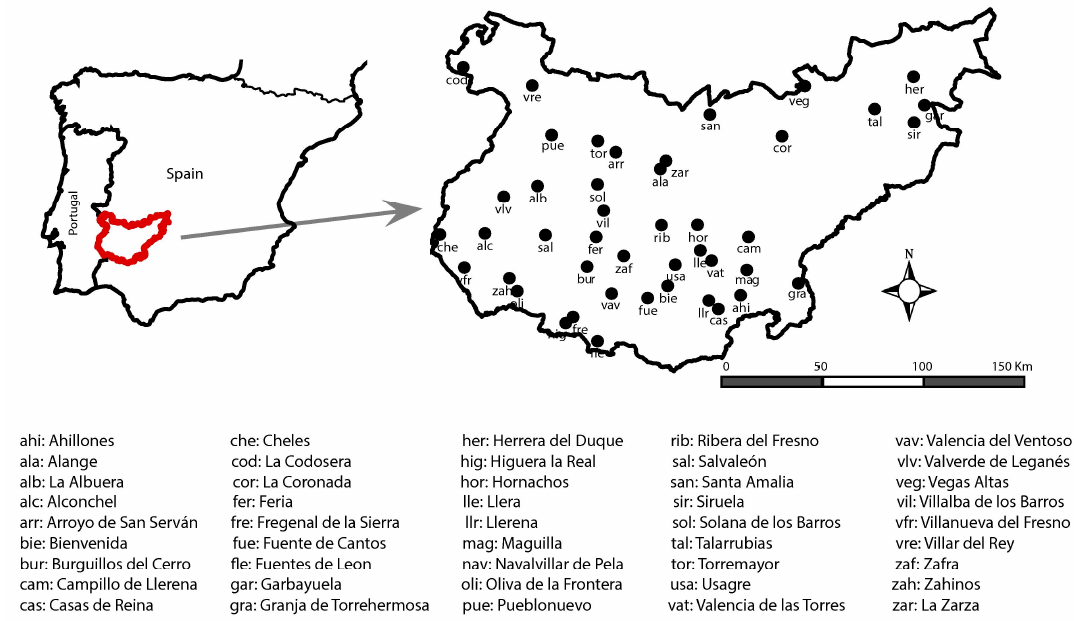
Figure 1. Spatial distribution of the WWPTs studied in the area of Badajoz, name of each plant, and their corresponding codes.